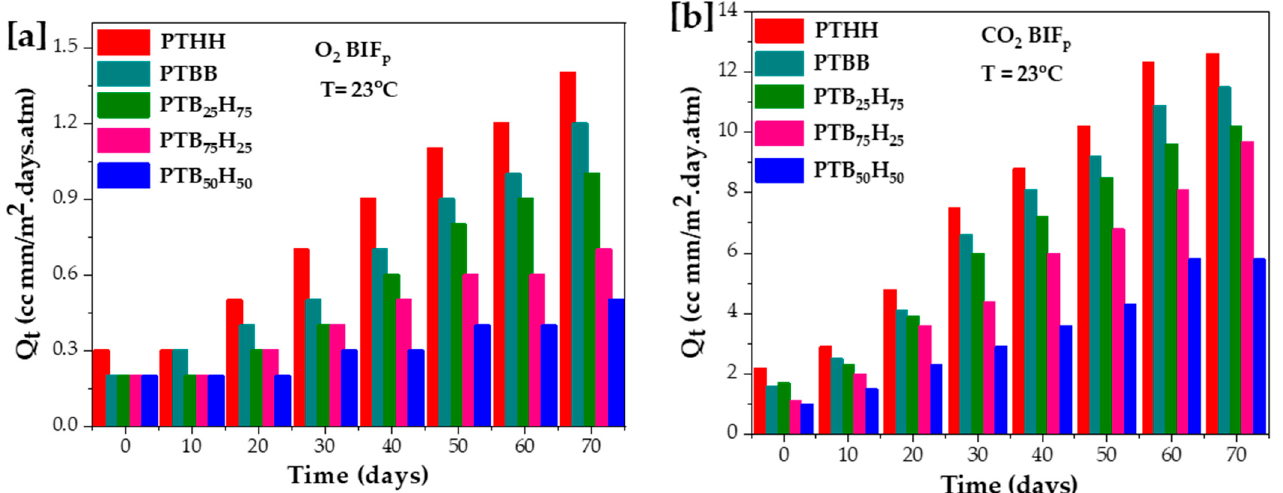
Figure 6. [ a] O 2 BIFp and [ b ] CO 2 BIFp for the poly(1,4-bis(2-hydroxyethyl)benzene thiophenedicarboxylate) (PTBB), poly(hexylene thiophenedicarboxylate) (PTHH), and poly(hexylene 2,5-thiophenedicarboxylate-co-bis(2-hydroxyethoxybenzene) copolyester films.